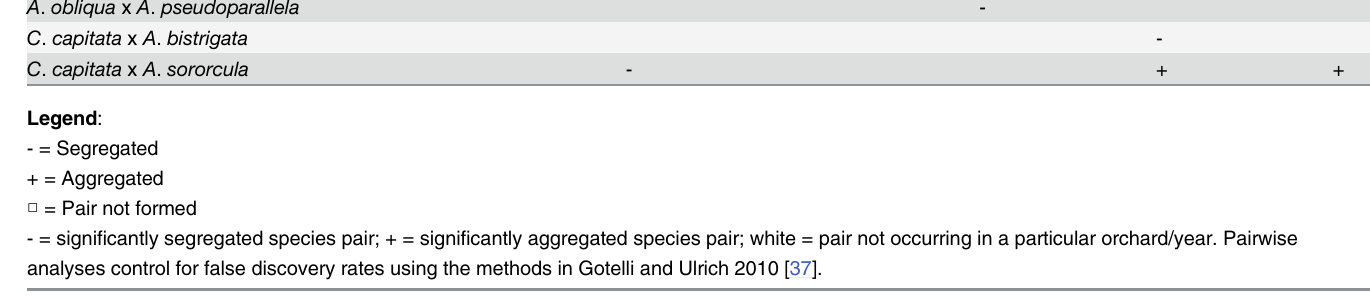
analyses control for false discovery rates using the methods in Gotelli and Ulrich 2010